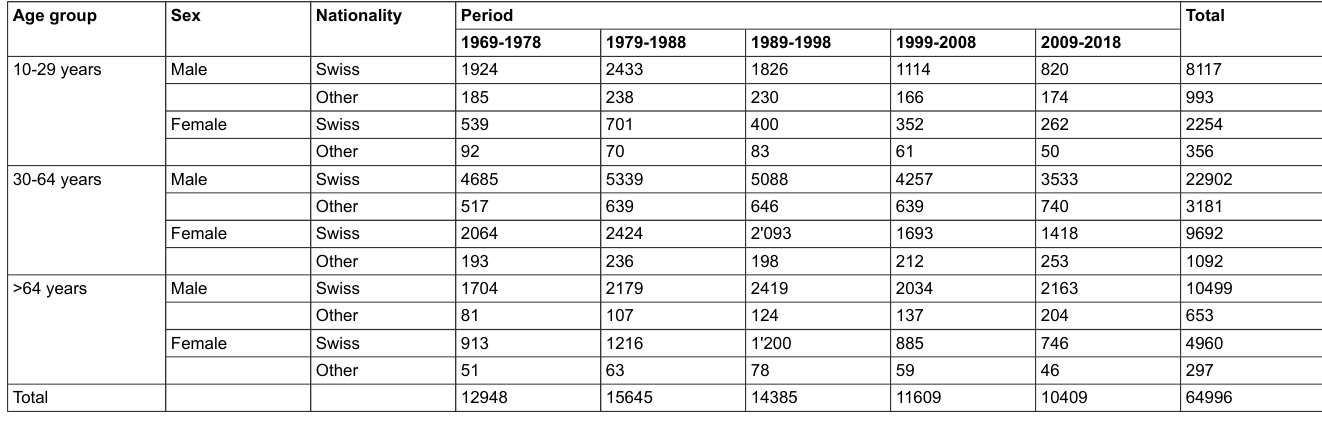
Table 1: Number of suicides in Switzerland